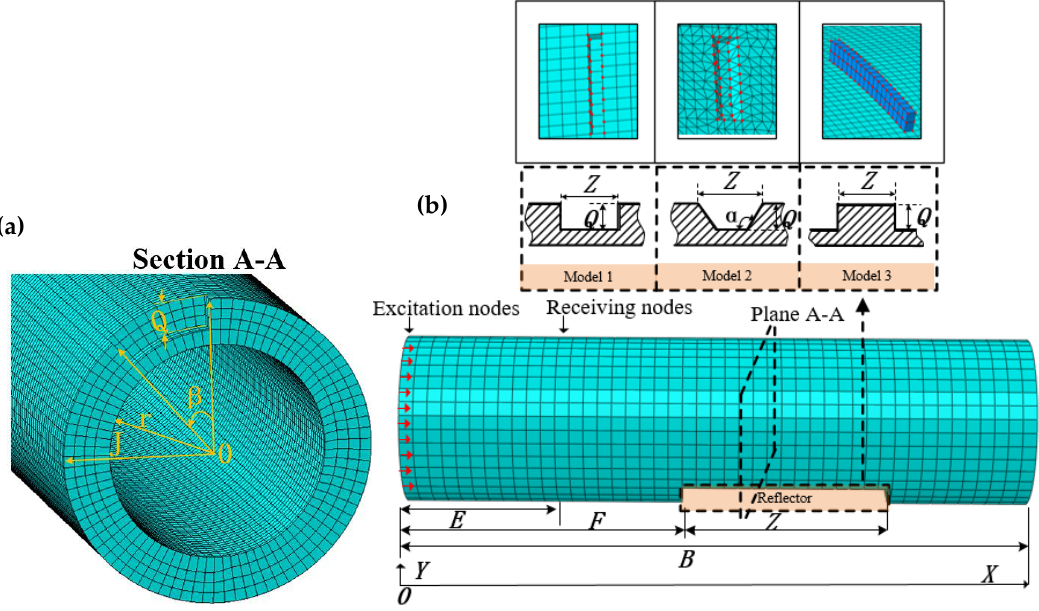
Figure 10. Schematic illustration of the finite element models in the sample pipe: ( a ) three-dimensional schematic diagram; ( b ) schematic of a sample pipe with different types of models.